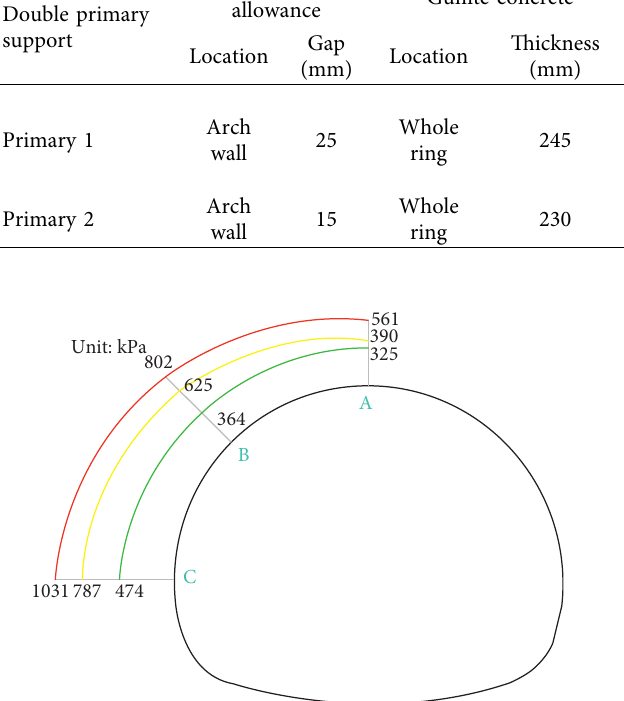
Figure 10: Schematic diagram of double primary support and secondary